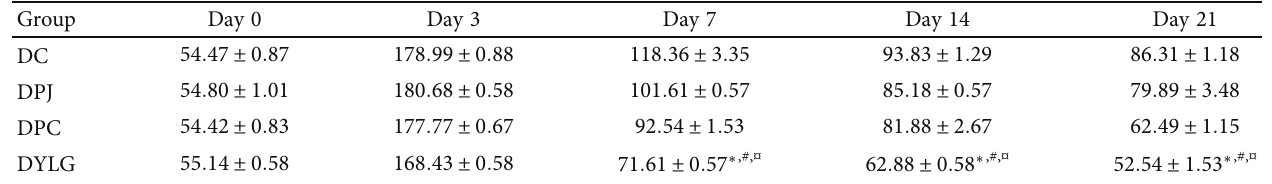
Table 6: The blood IL-6 level (ng/ml) in T2DM rats on days 0, 3, 7, 14, and 21 ( n = 24 per group).